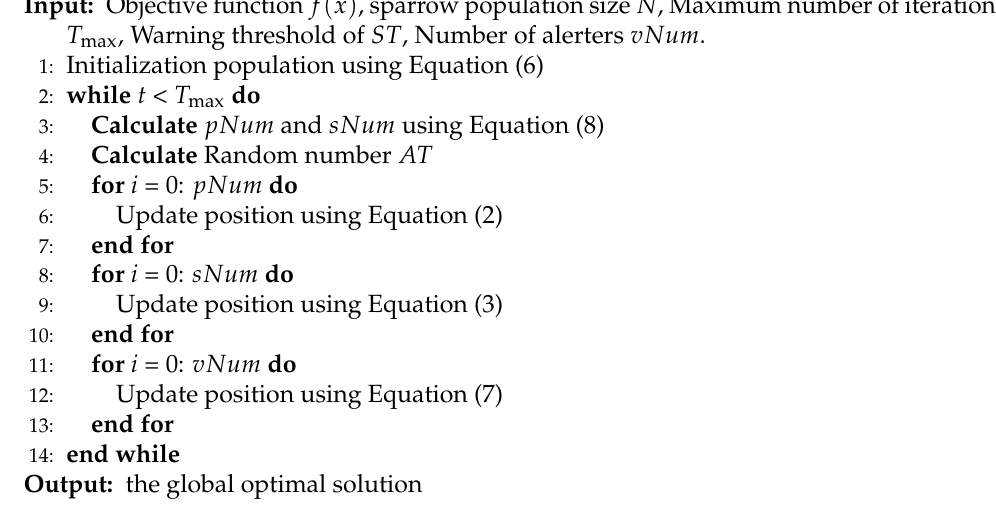
Algorithm 1 Pseudo Code of CMASSA